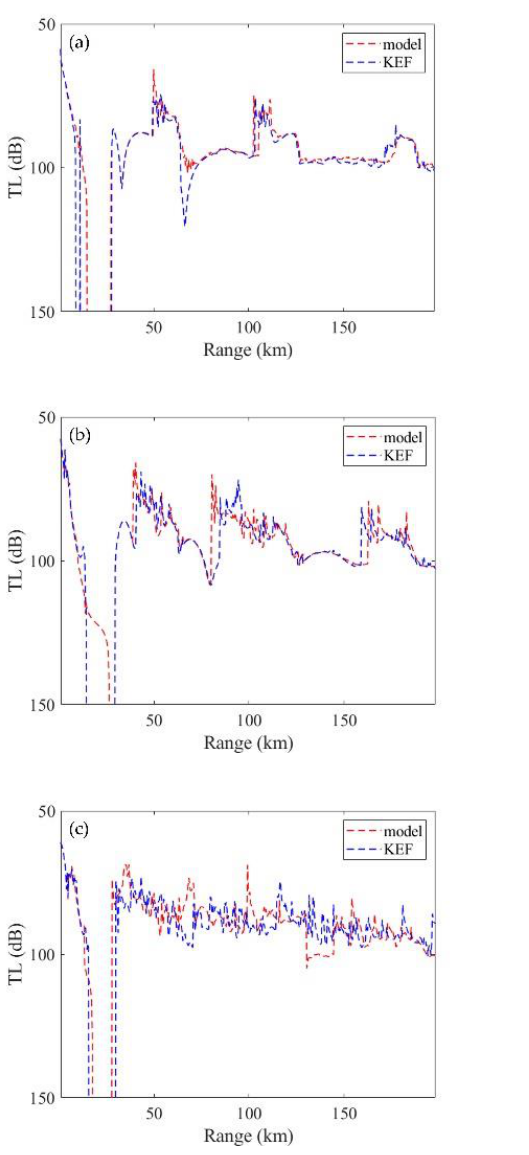
Figure 9. Comparison of the model and actual TL under different SD and frequency on 1 January: ( a ) f = 50 Hz, SD = 100 m; ( b ) f = 50 Hz, SD = 300 m; ( c ) f = 50 Hz, SD = 500 m; ( d ) f = 400 Hz, SD = 100 m; ( e ) f = 400 Hz, SD = 300 m; ( f ) f = 400 Hz, SD = 500 m. When the SD was 100 m, the difference between the TL calculated by the model and the TL calculated by the actual ocean front was very small at low and high frequencies. At 300 m, in terms of the overall distribution trend, the results of the model were similar to the calculation results under the actual ocean front environment. At 500 m, in terms of the overall trend, the results of the model and the actual results also showed many similarities.